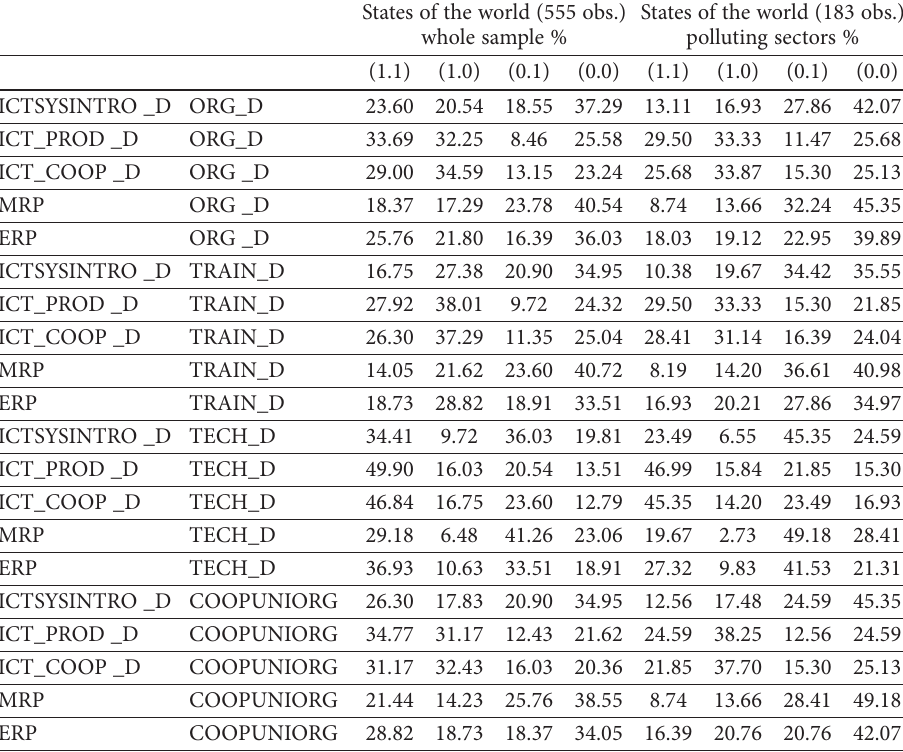
Table A1. State of the world distribution